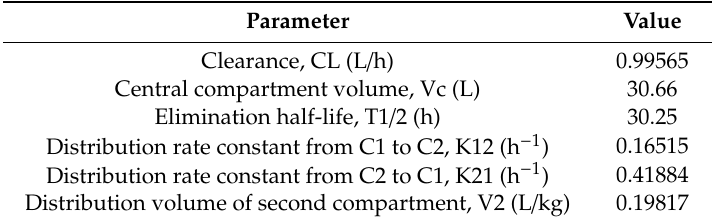
Table 3. Pharmacokinetic (PK) parameters from the two-compartmental model calculated by the PKPlus ™